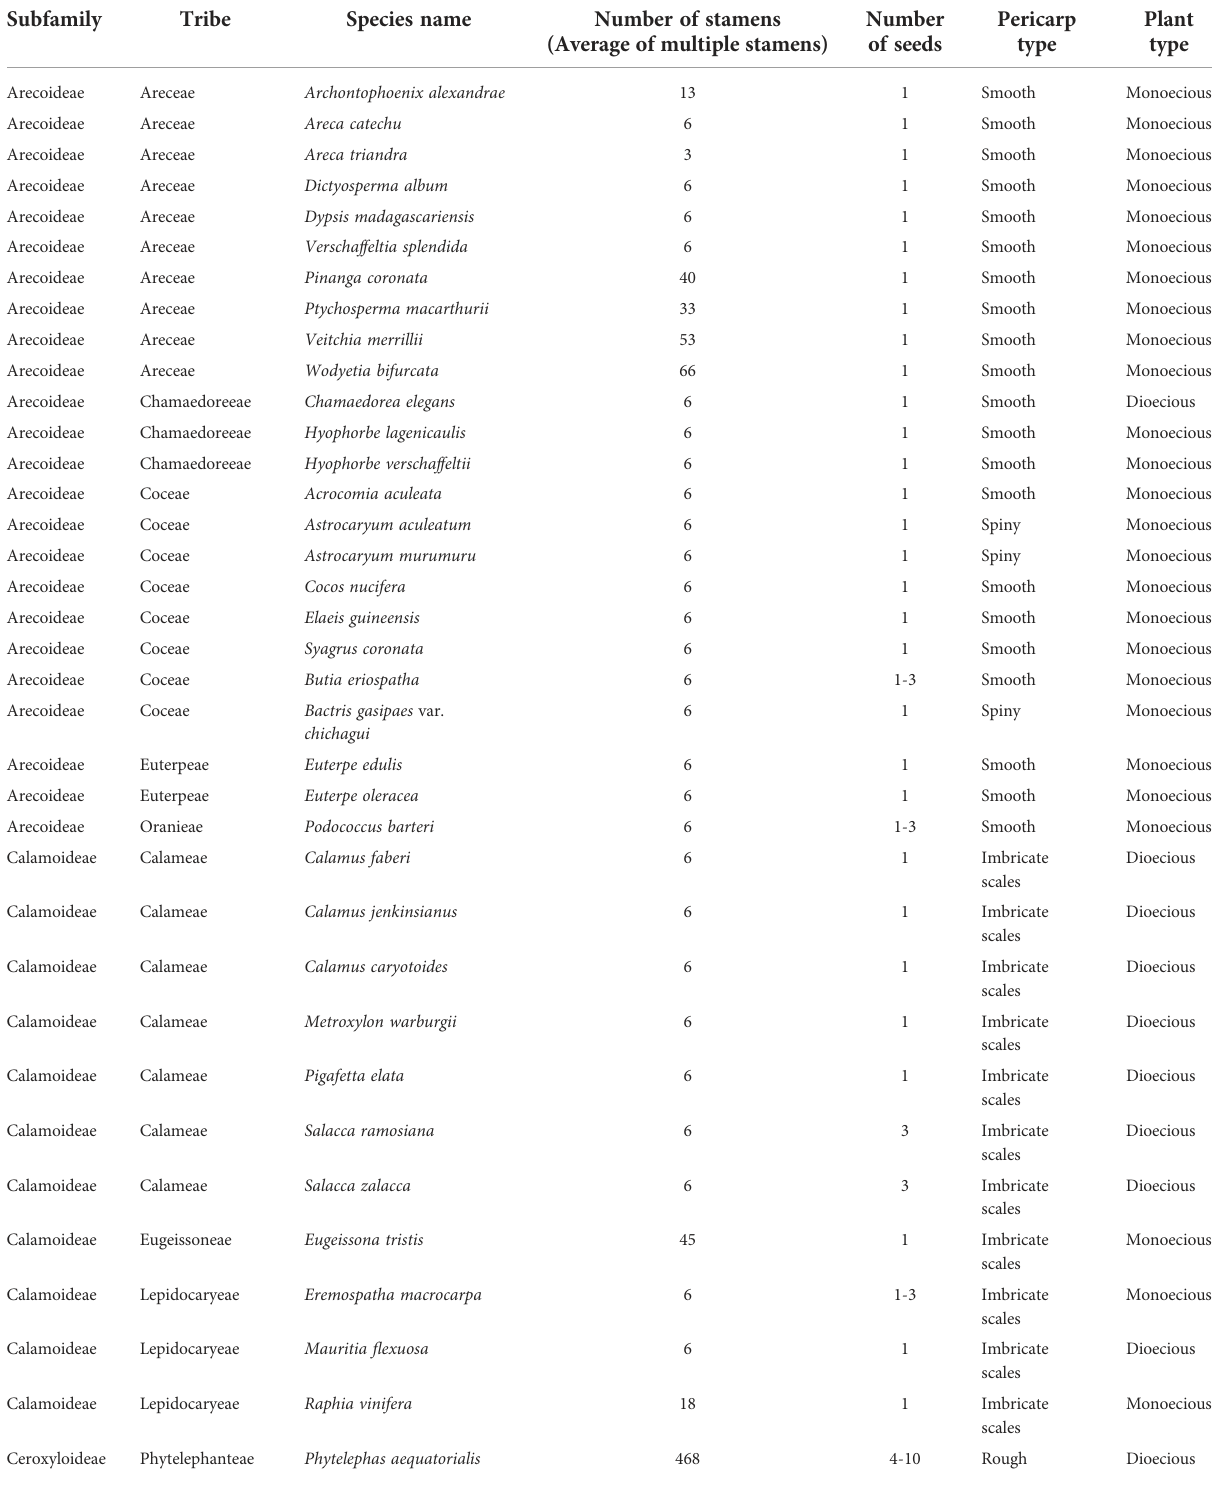
TABLE 5 Statistics of morphological characteristics of Arecaceae. Subfamily